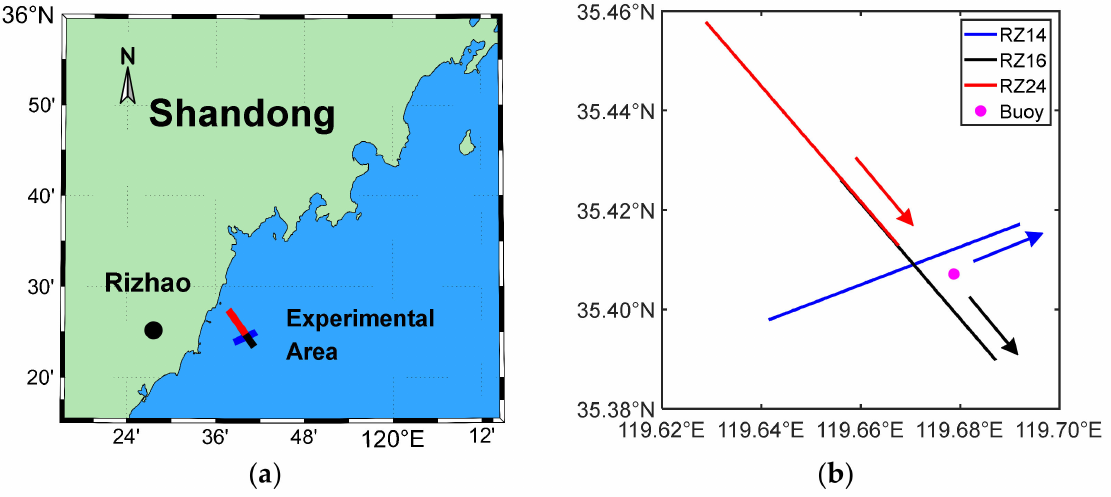
Figure 3. ( a ) Rizhao sea experimental area. ( b ) Flight tracks.